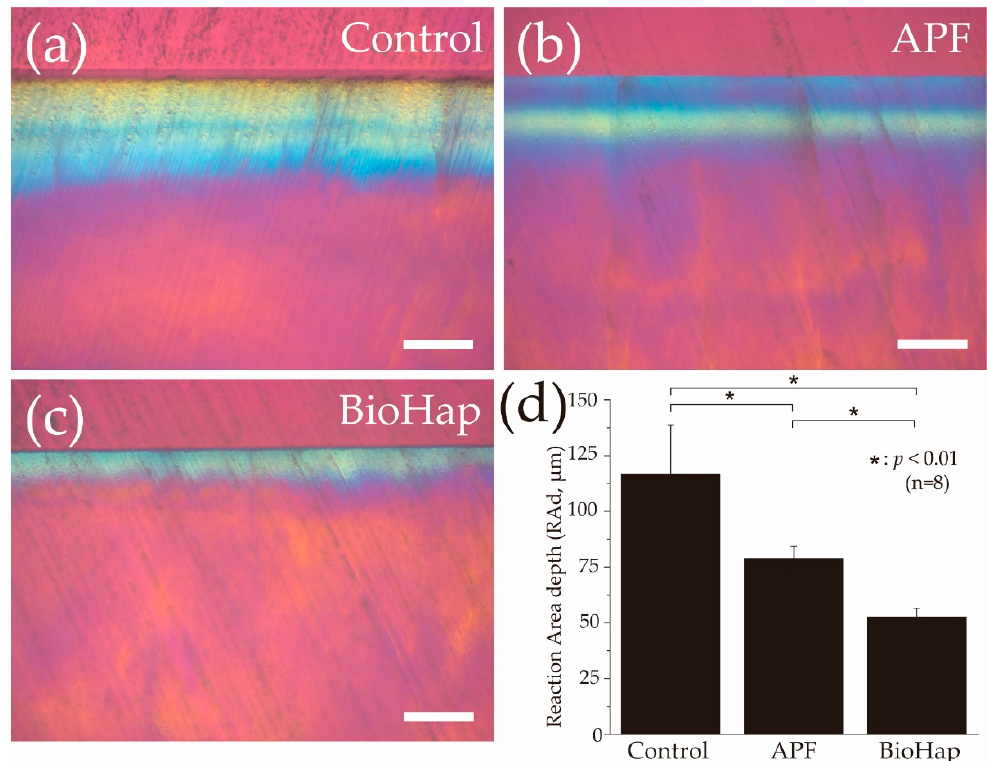
Figure 5. Polarizing microscope images of enamel cross-sections after acid challenge. Polarizing microscope cross-sectional images of the experiment surface after acid challenge in the ( a ) control, ( b ) APF, and ( c ) BioHap groups. Scale bar is 100 µm. ( d ) Graphical representation of reaction area depth due to demineralization (n = 8, * p < 0.01).